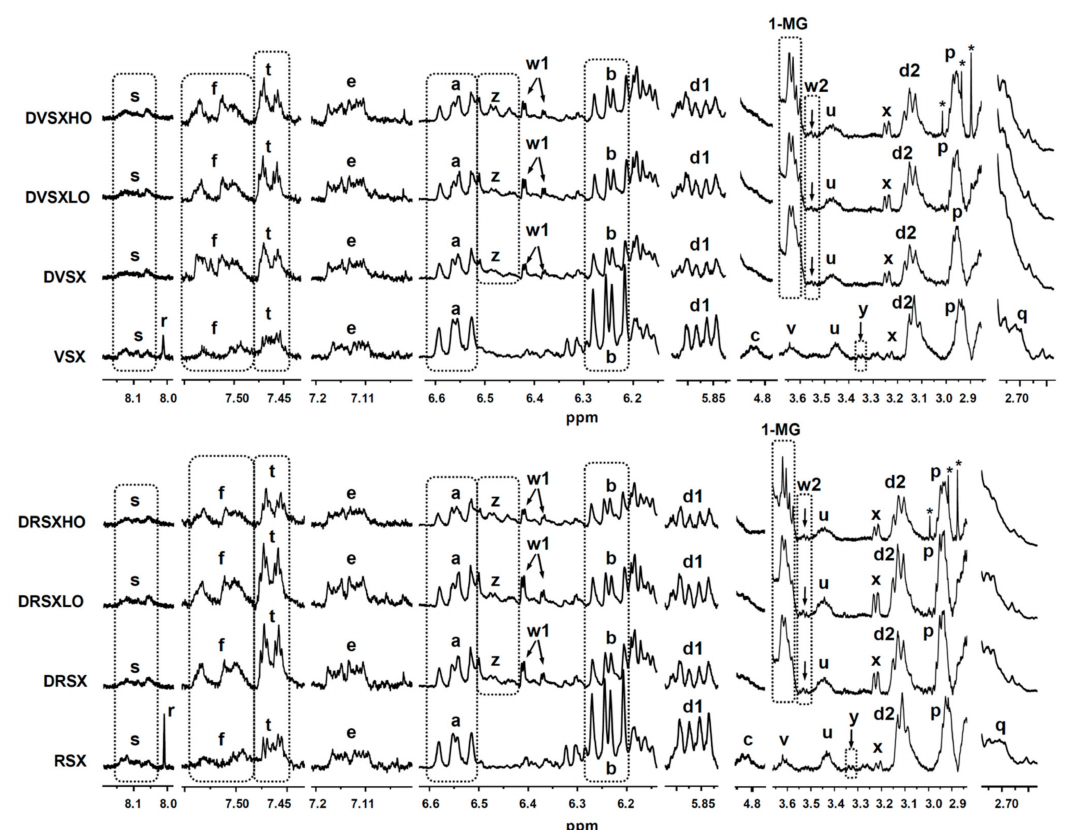
Figure 2. Enlargements of some regions of the 1 H NMR spectra of the highly oxidized virgin and refined soybean oils (VSX and RSX), and of the lipid extracts obtained after their in vitro digestion in the absence of ovalbumin (DVSX and DRSX), as well as in the presence of a low (DVSXLO and DRSXLO) and a high proportion of ovalbumin (DVSXHO and DRSXHO). The signal letters agree with those in Tables S4, S5, S7, S8 and S9. Signals marked with an asterisk are considered to come from the ovalbumin sample used. The plots corresponding to the same 1 H NMR spectral region are presented at a fixed value of absolute intensity, for them to be valid for comparative purposes. 1-MG: